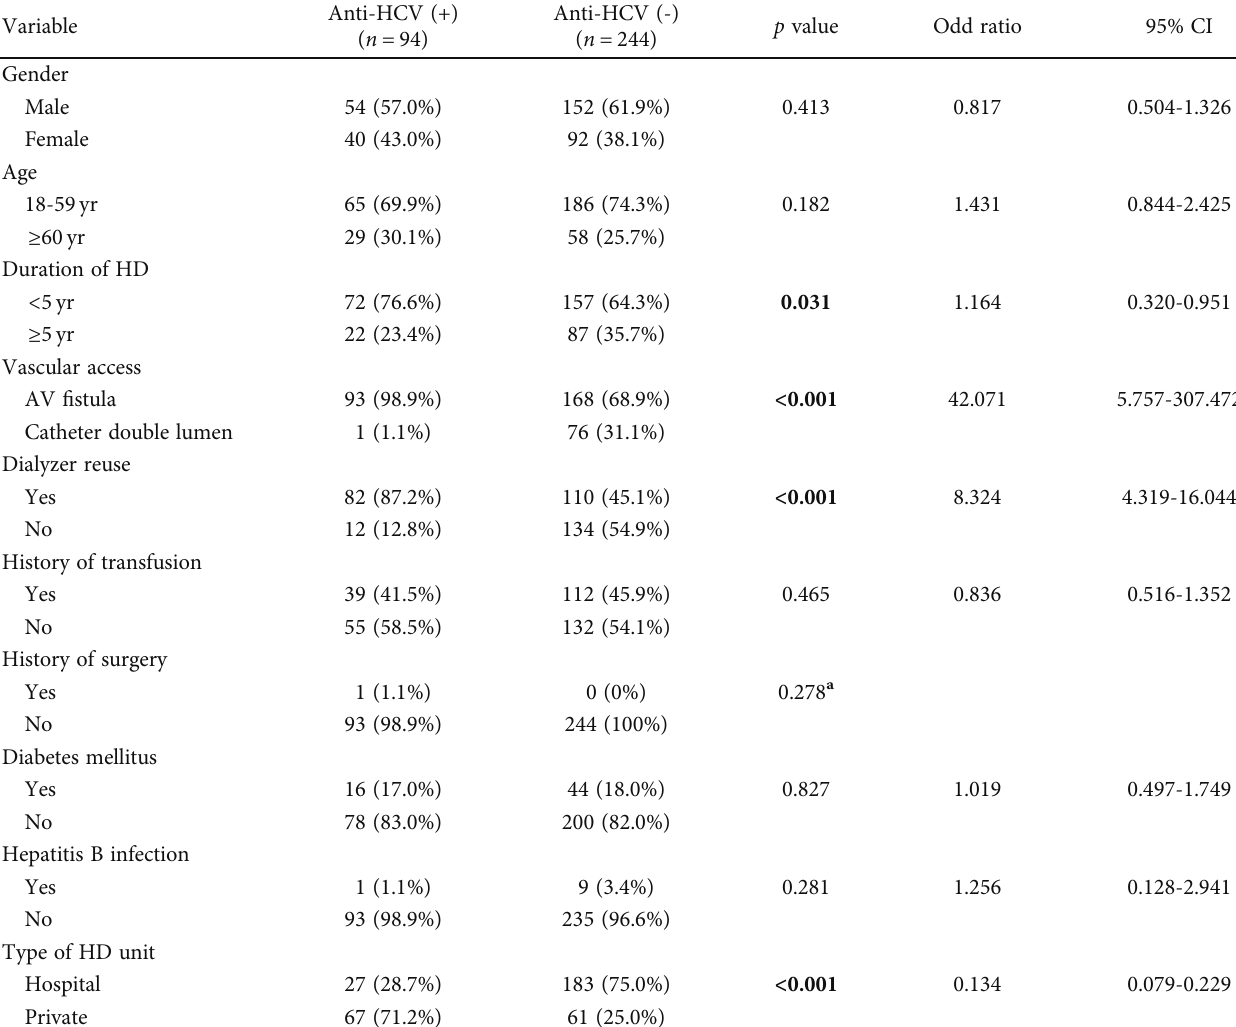
Table 2: Association of risk factors with HCV infection in hemodialysis